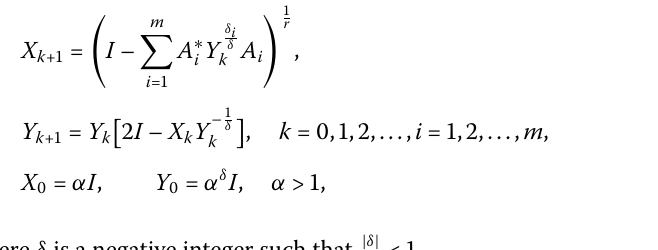
Algorithm . (INVERSE-FREE Algorithm) Consider the iterative